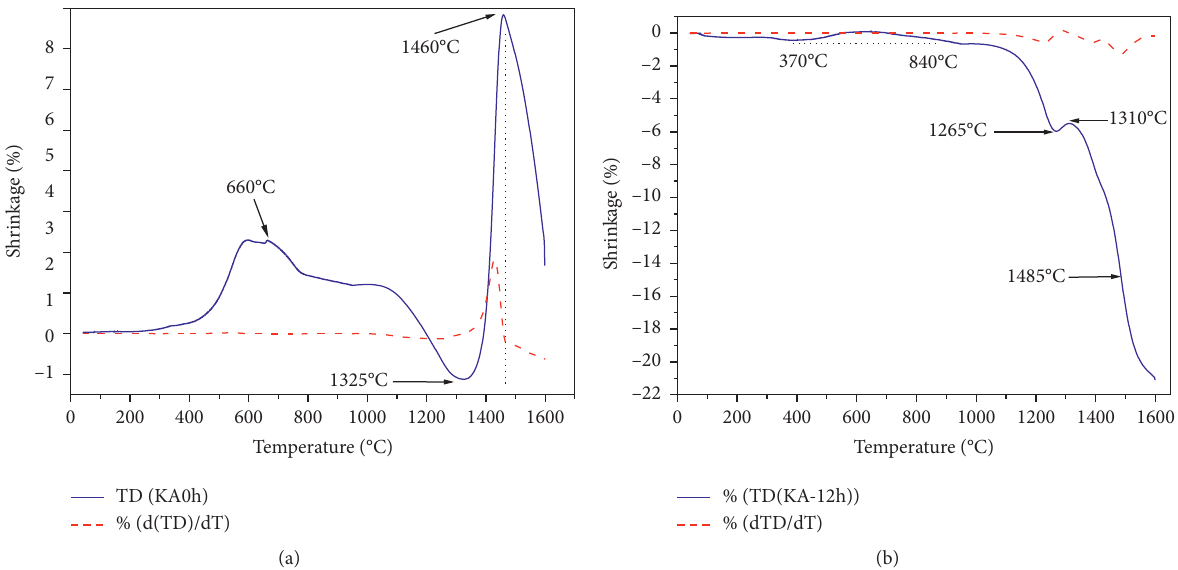
Figure 8: Thermodilatometric behavior of the mixture unmilled KA0h (a) and attrition-milled mixture KA12h